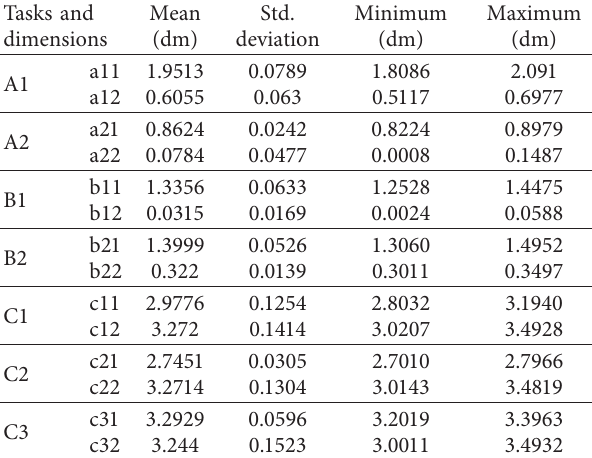
Table 4: Features of the 14 dimensions. Tasks and dimensions